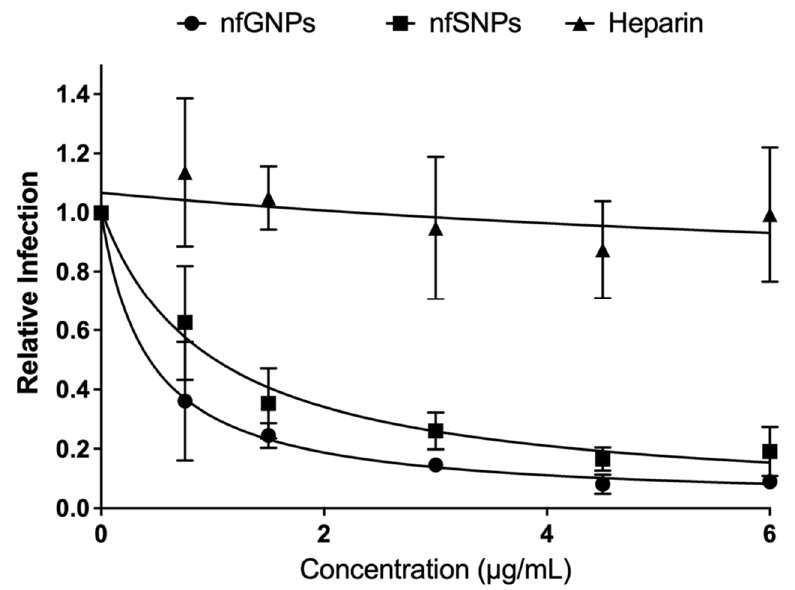
Figure 6. nfGNPs inhibit HPV16 PsV pseudo-infection better than heparin. Inhibition of PsV pseudo-infection by nfGNPs, nfSNPs and heparin. Pseudo-infected 293TT cell fluorescence was quantified by flow cytometry and plotted relative to the non-treated PsV control. The graphs represent the mean and standard deviation of three independent experiments.